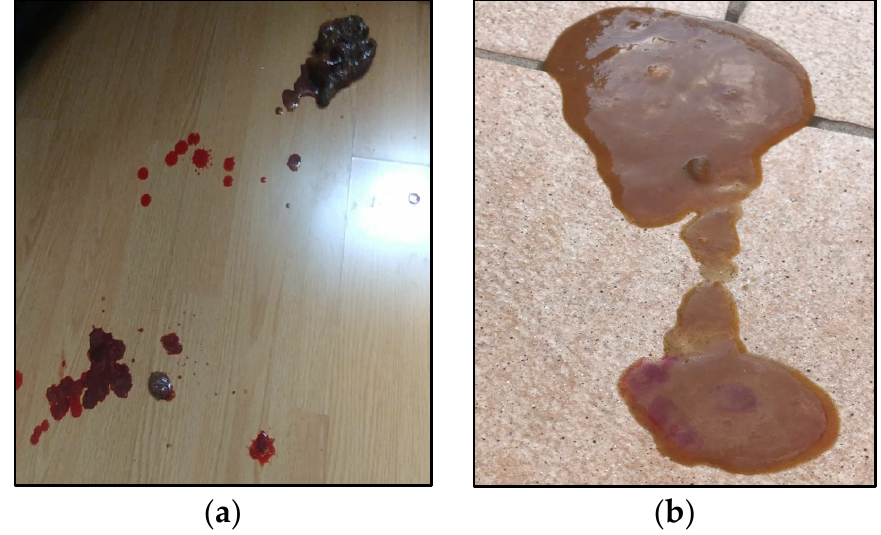
Figure 1. Puppy’s fecal characteristics upon presentation ( a ) and ( b ) the day before hospitalization . Table 1. Principal clinical findings and haemogas analysis results recorded during dog ER examination.